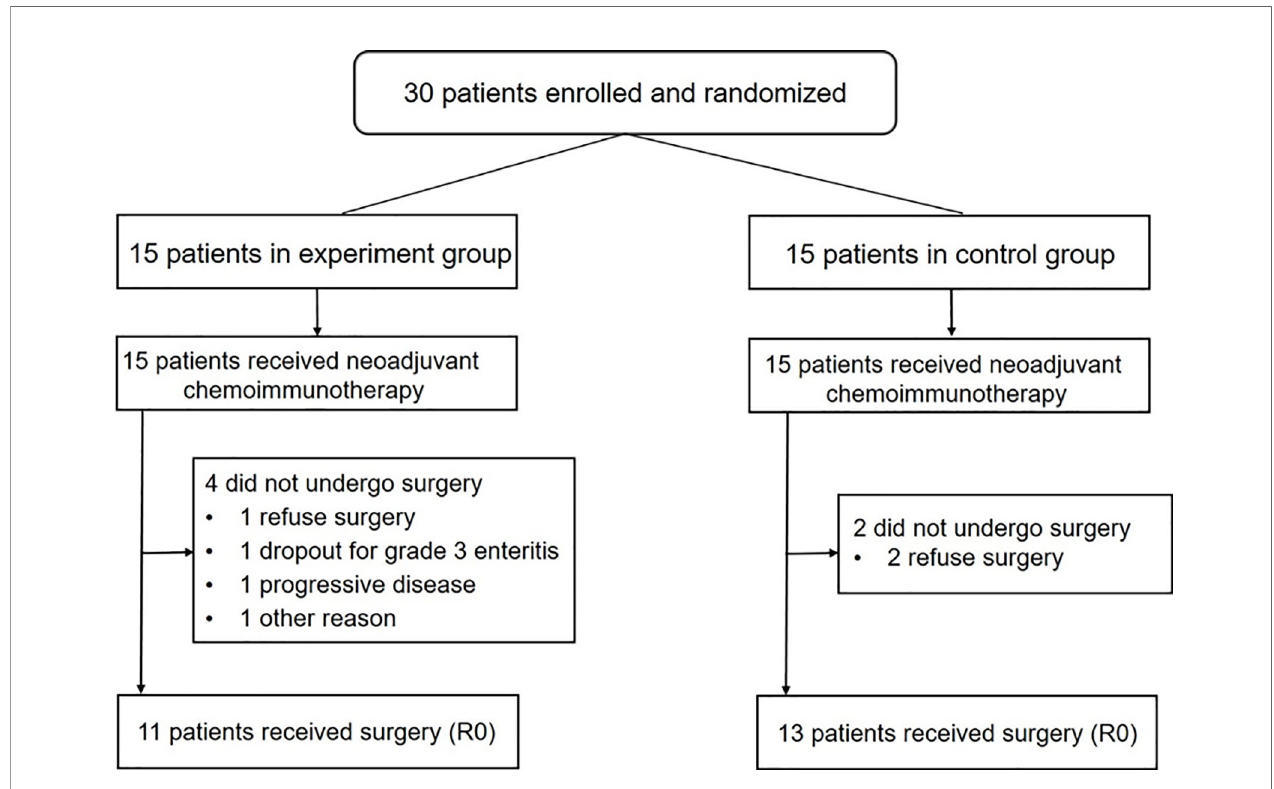
FIGURE 1 | Consolidated Standards of Reporting Trials (CONSORT)